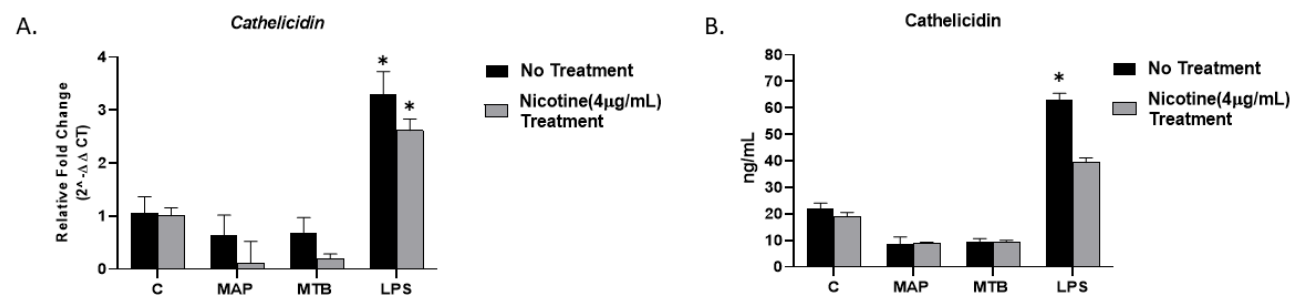
Figure 5. Effect of nicotine in cathelicidin expression on infected macrophages. THP-1 PMA differentiated macrophages were infected with MAP and MTB, or treated with LPS for 24 h, then treated with nicotine (4 µg/mL). Expression of cathelicidin was measured by ( A ) RT-PCR and ( B ) ELISA, respectively. All experiments were performed in duplicates. MAP: Mycobacterium avium paratuberculosis . MTB: Mycobacteria tubercalusis . LPS: lipopolysaccharide derived from Escherichia coli ATCC 8739. * p < 0.05.